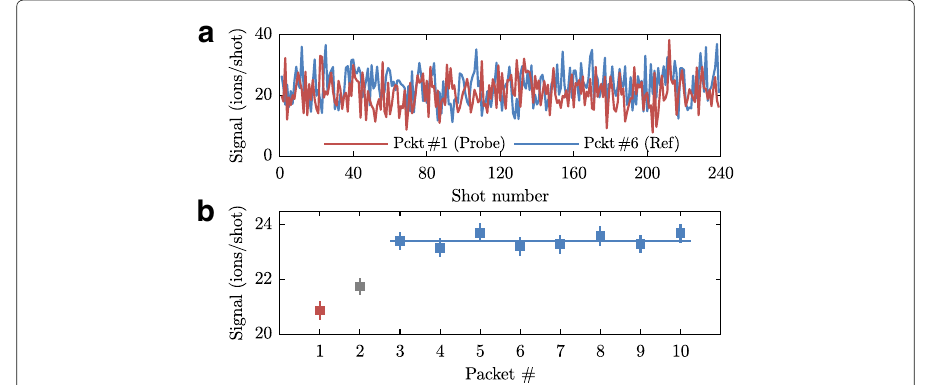
Fig. 11 a Single-shot measurements of ammonia packets after 90 round-trips. The red trace corresponds to the probe packet, the blue trace to one of the reference packets. b 240-shot averages of the probe packet (red), a discarded reference packet (grey), and 8 reference packets (blue). The error bars denote standard errors of the means. The blue line depicts the average of the 8 reference